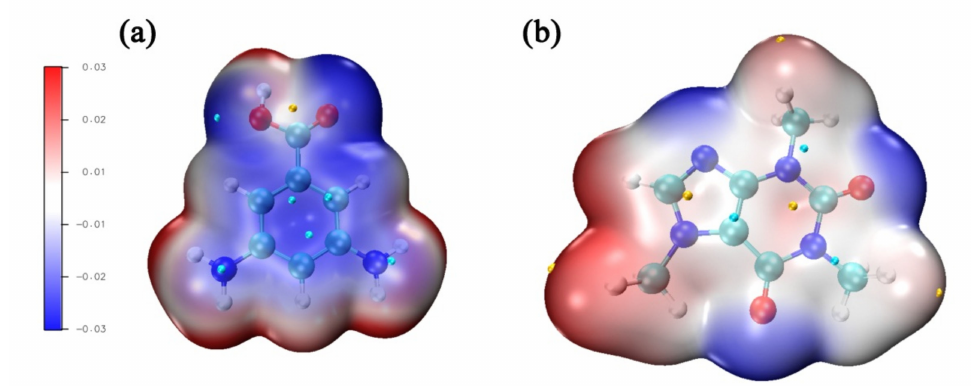
Figure 1. ( a ). The molecular electrostatic potential of 3,5-diaminobenzoic acid. ( b ). The molecular electrostatic potential of ca ff